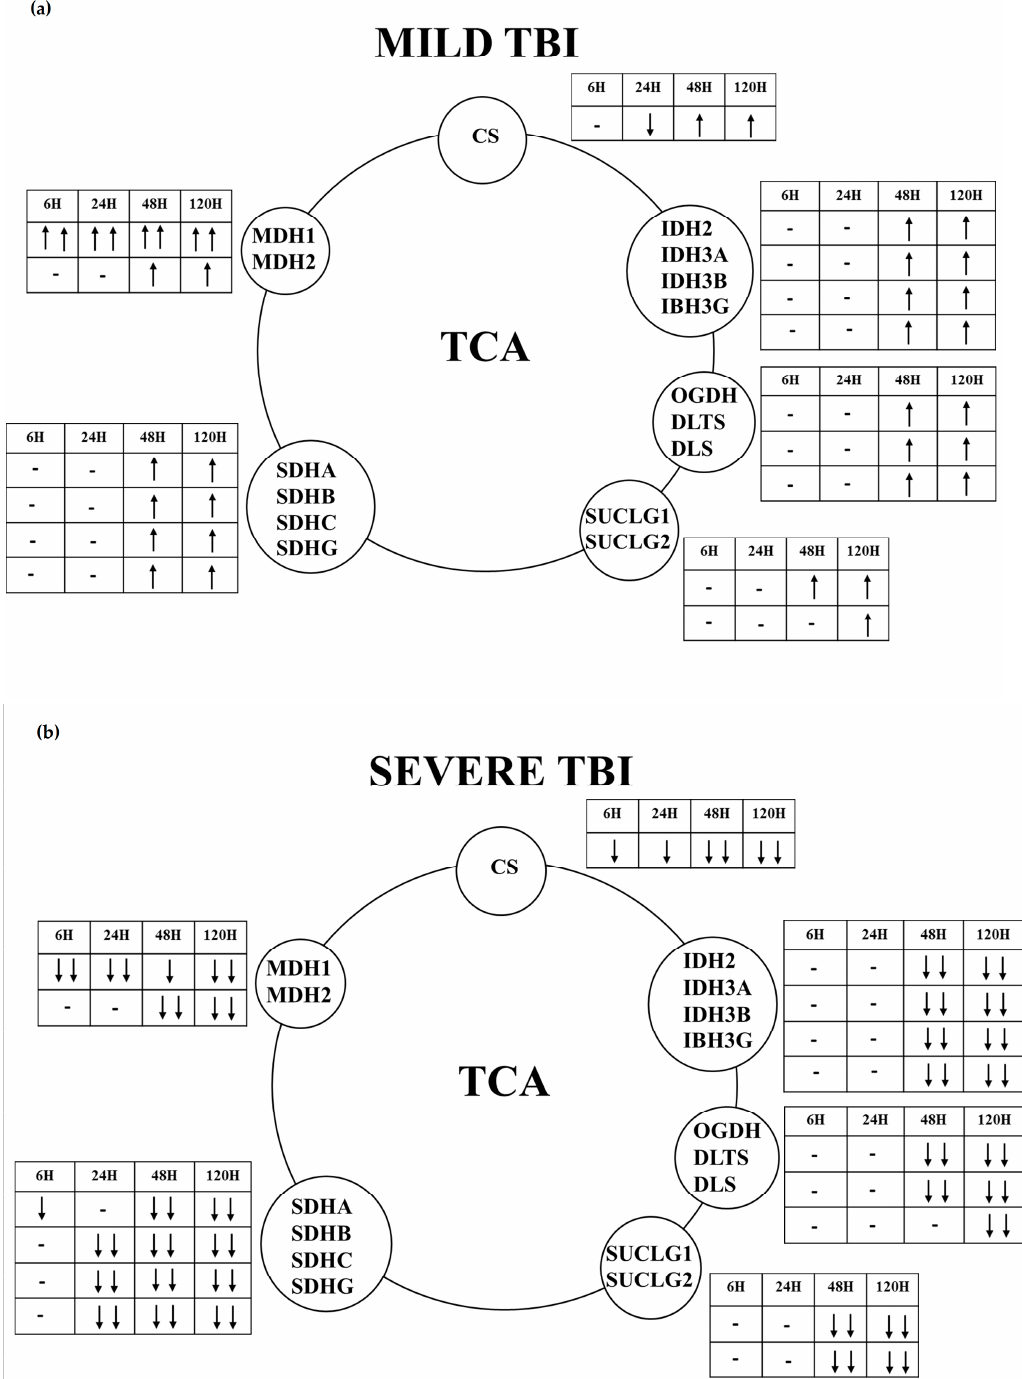
Figure 10. Schematic representations of the changes in the expressions of the genes encoding for the main enzymes of the tricarboxylic acid cycle (TCA) cycle occurring at different times following a mild ( a ) or severe ( b ) TBI.